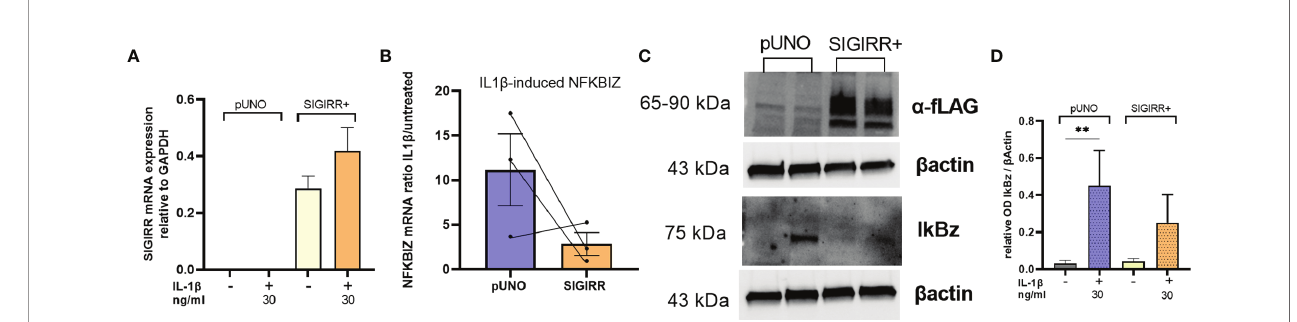
FIGURE 5 | SIGIRR overexpression downregulates IL1 signaling in RCC cells. SIGIRR containing plasmid or empty vector were transiently transfected into A498 cells to induce SIGIRR overexpression (A) ; transfected cells were analyzed for their responsiveness to IL1 b (30 ng/ml) in terms of NFKBIZ (B) mRNA levels relative to GAPDH and B-actin expressed as ratio of IL1-treated/untreated (mean ± SEM of three independent experiments). (C) Western blot analysis of one representative experiment to analyze SIGIRR overexpression and IkBz regulation before and after IL1 stimulation. (D) Densitometric analysis of Western blot results (mean ± SEM of four independent